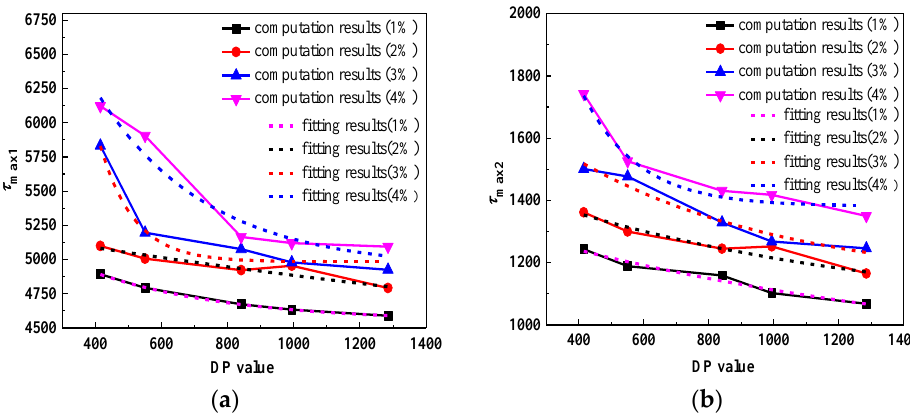
Figure 7. Relations between larger time constants and DP values. ( a ) Relations between τ max1 and DP values ( b ) Relations between τ max2 and DP values.